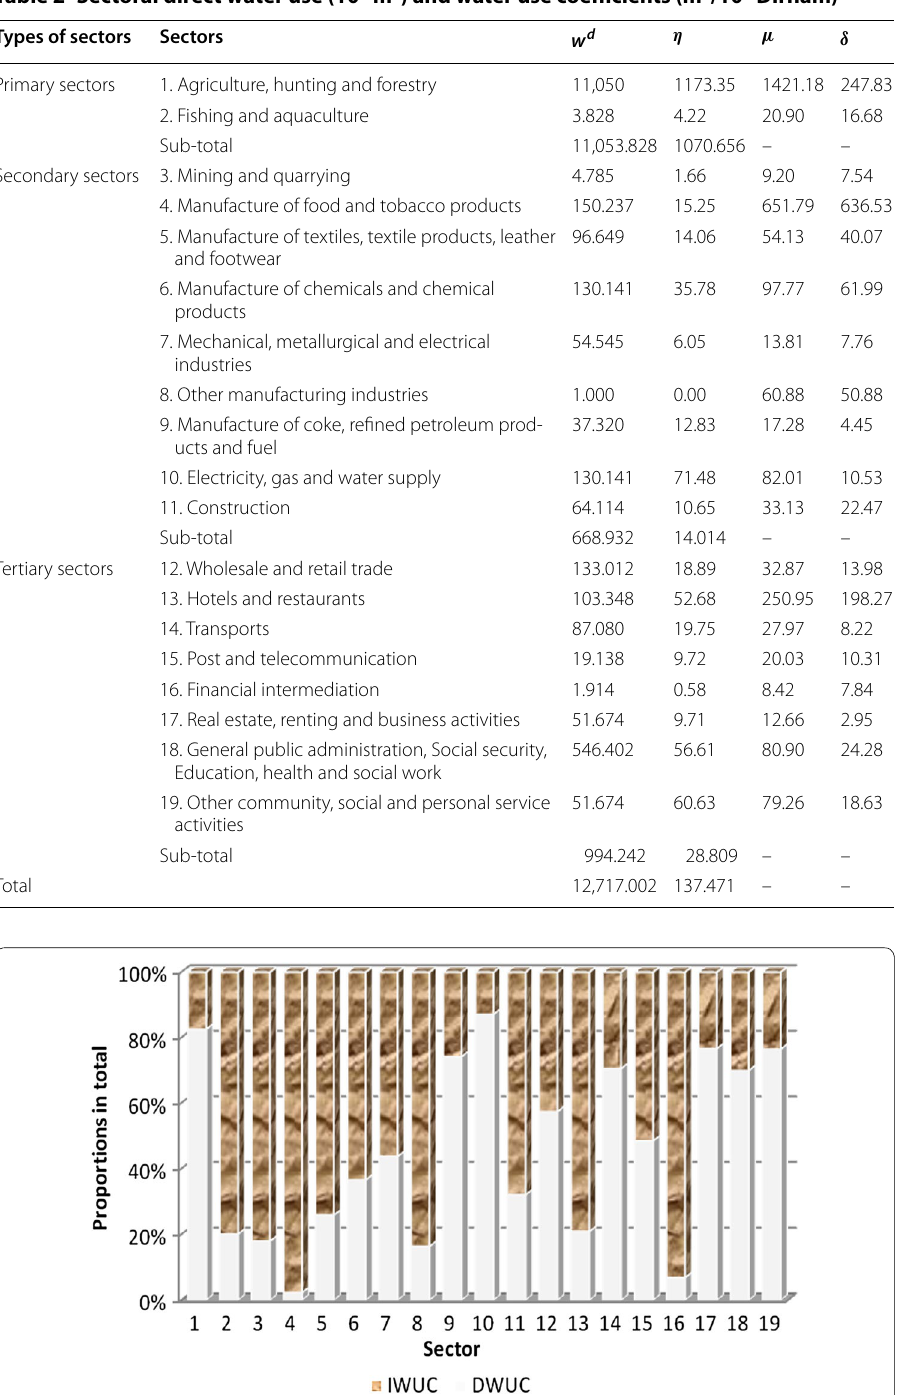
Fig. 4 Proportion of DWUC and IWUC contributions to total water use coefficient of each sector